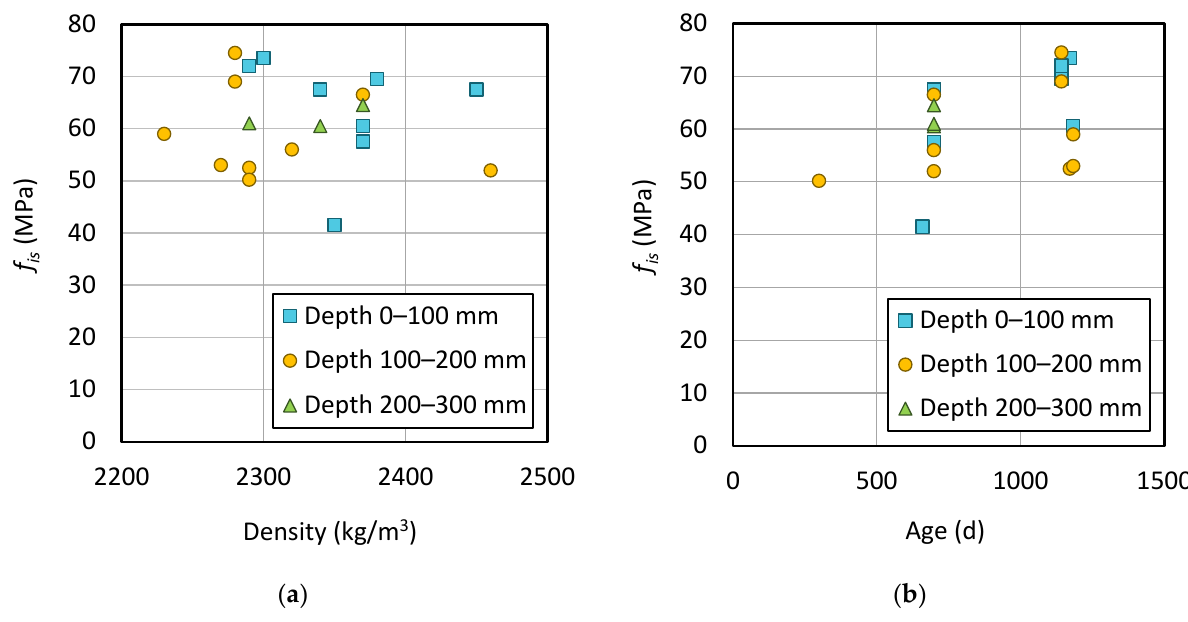
Figure 14. In-situ compressive strength, f is , versus ( a ) density, and ( b ) age of the concrete for test specimens taken from cores drilled on the foundations, for different depths from the top concrete surface.